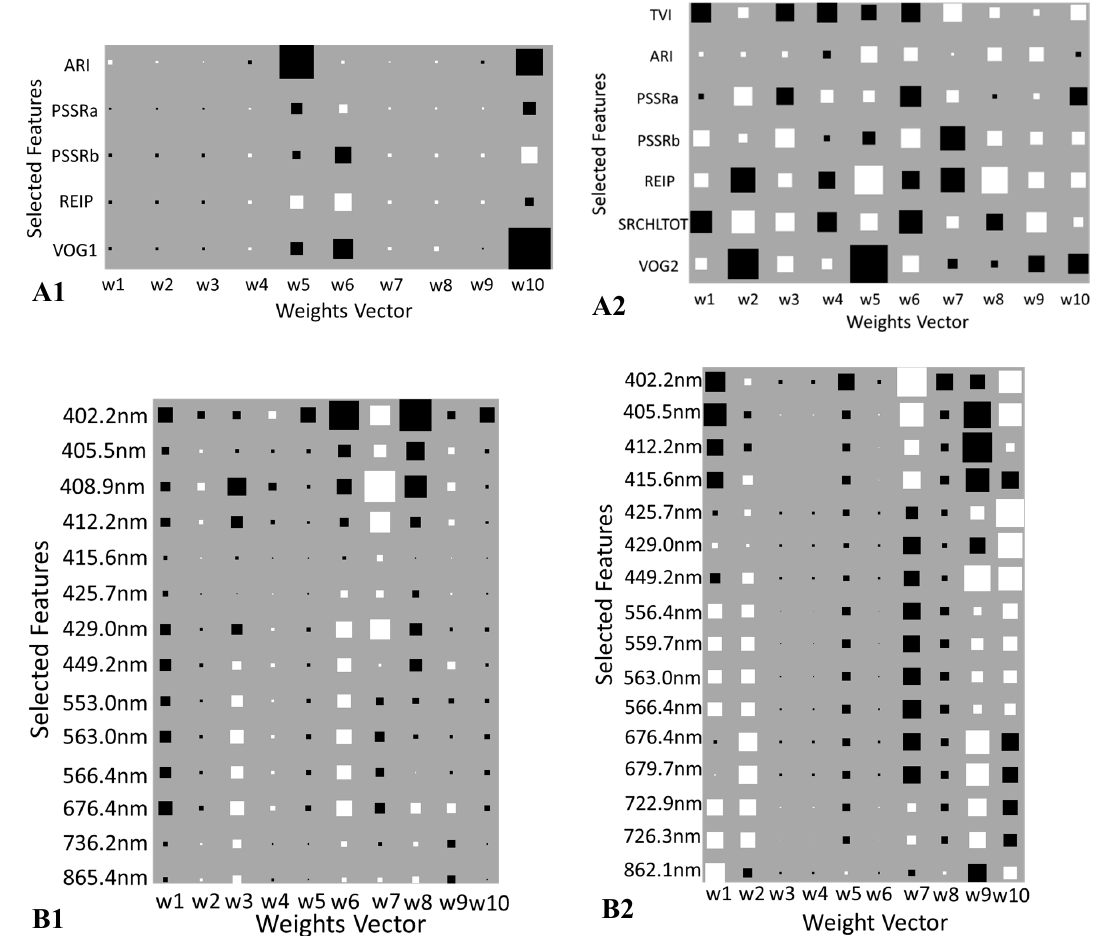
Figure 6. The Hinton diagram of the trained MLP–ARD algorithm. The magnitude of the square shows the value of the weight. White squares represent positive weight values, while the black squares represent negative weight values. Diagrams A1 and B1 represent the performance of the model before the outlier elimination and A2 and B2 the performance of the model after the outlier elimination. In row A ( A1 , A2 ), the models that use the VIs as input features are presented, while the respective models that use the EWs as input features are presented in row B ( B1 , B2